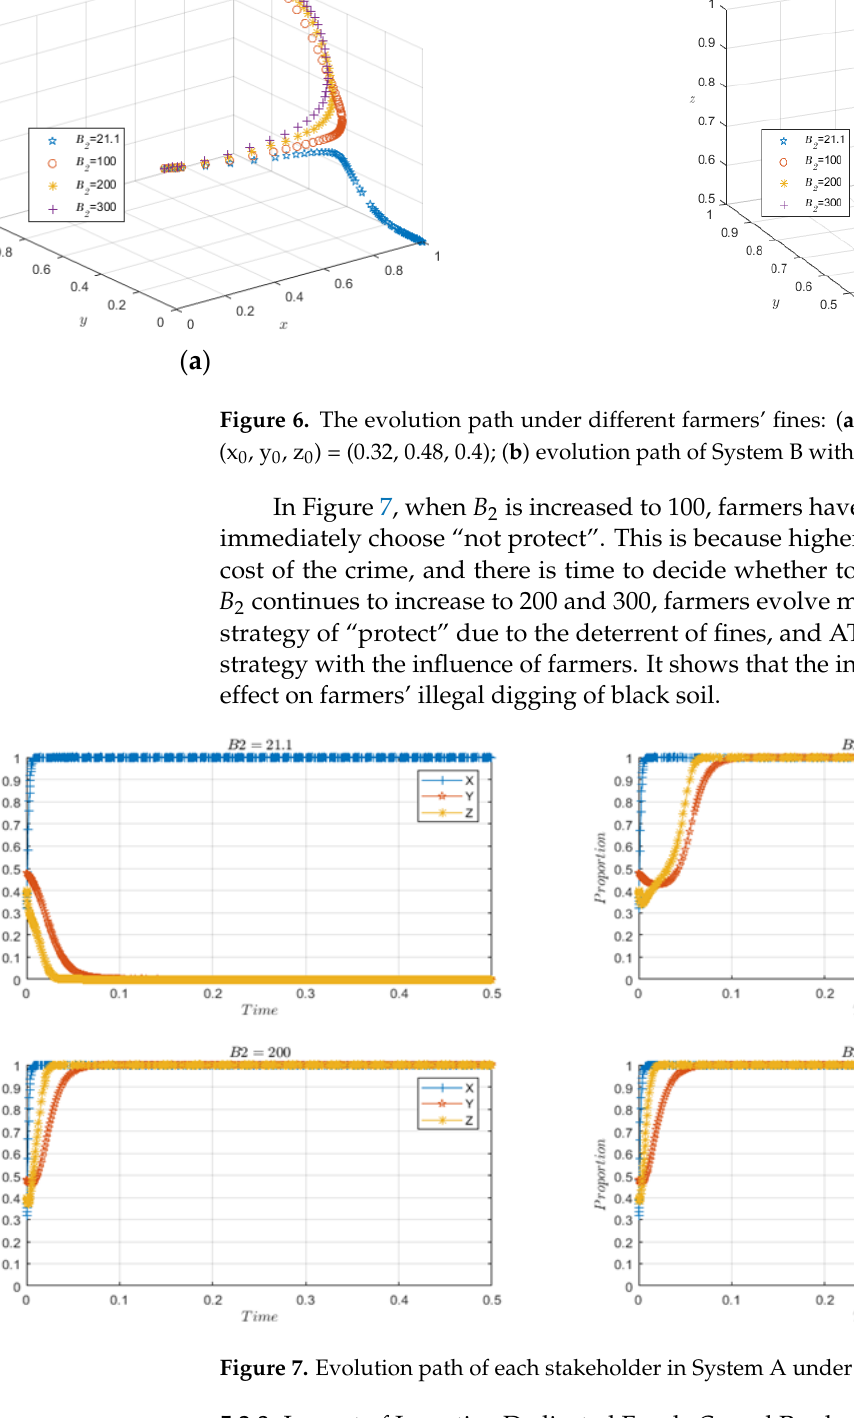
Figure 7. Evolution path of each stakeholder in System A under different farmers’ fines.